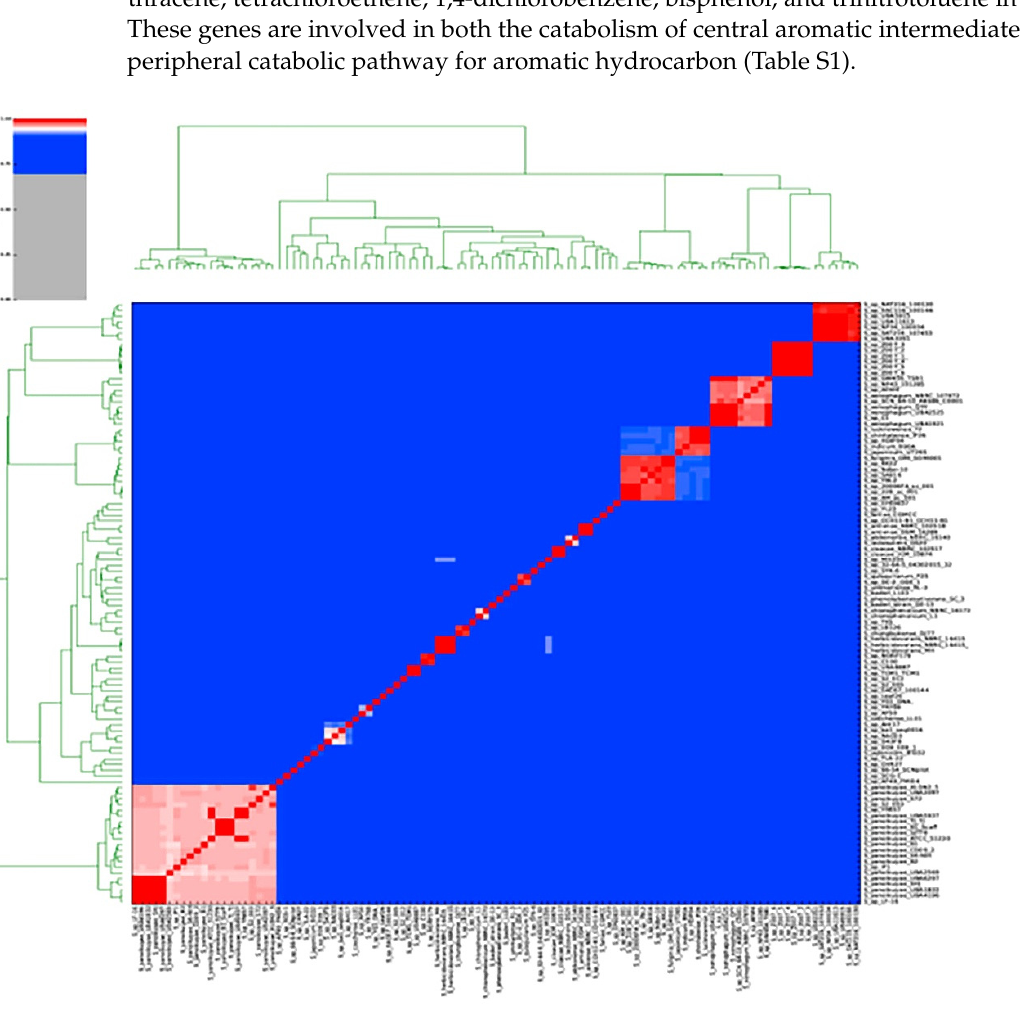
Figure 3. ANIm % Identity of 106 Sphingobium Strains. ANI analysis based on MUMmer alignment of the genome sequences was performed using PYANI.